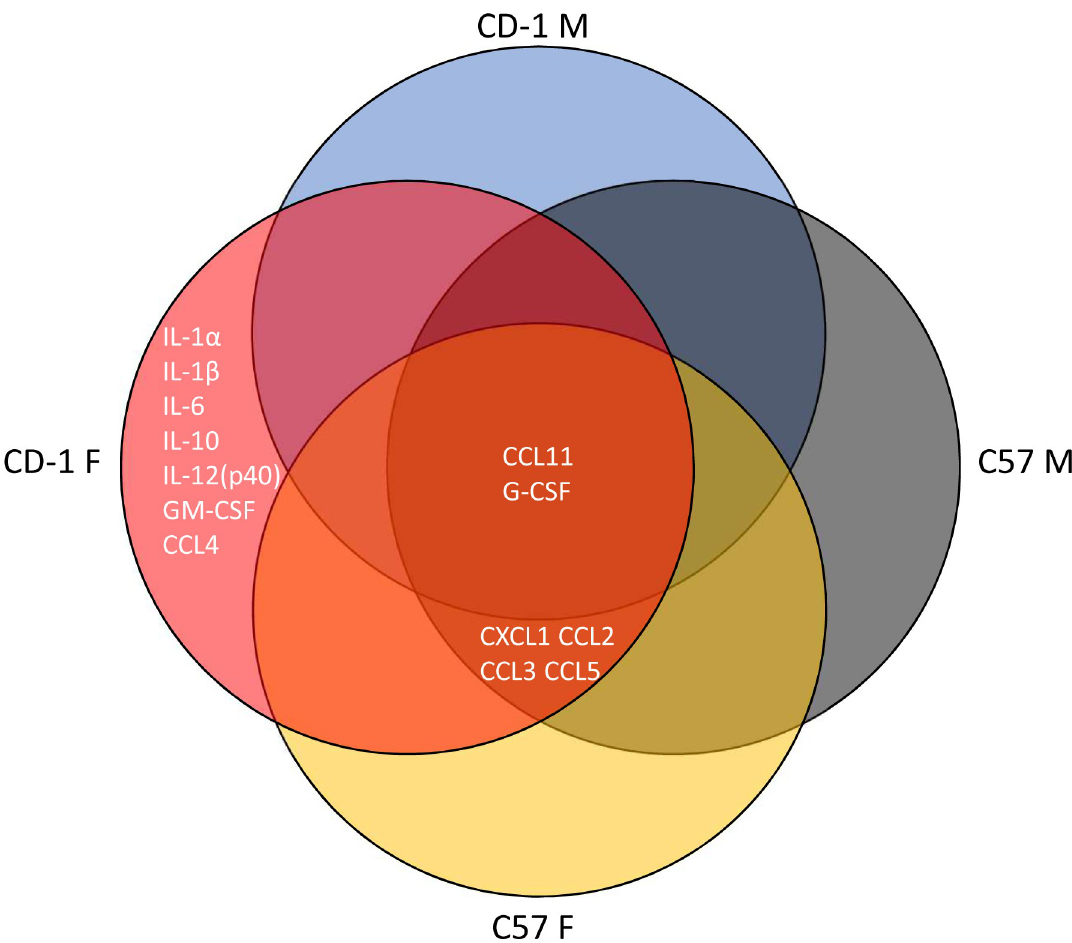
Fig 5. Venn diagram of significant cytokine elevations in brain following LPS treatment according to sex and strain.